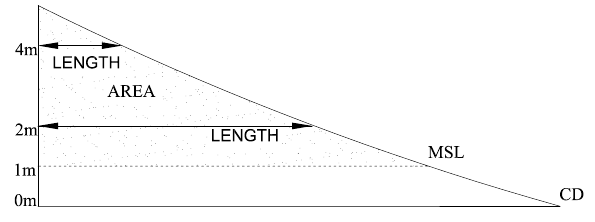
Fig. 4. Beach profile area (volume per metre) above 1m chart datum (CD) and profile length at the 2m and 4m CD contour.